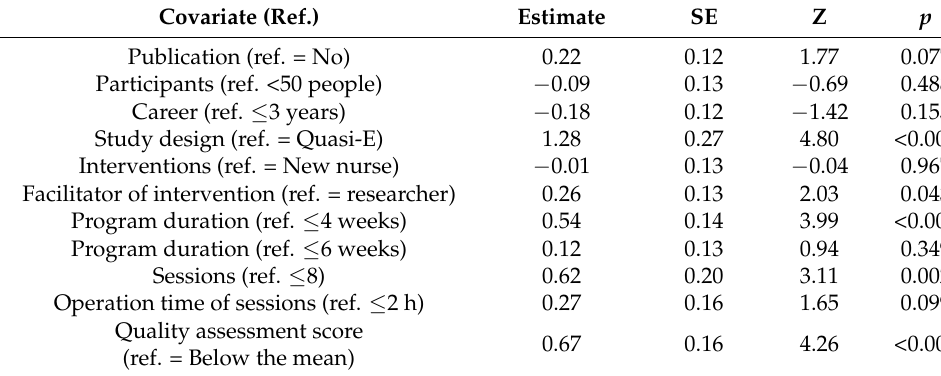
Table 5. Meta-regression analysis evaluating job satisfaction.